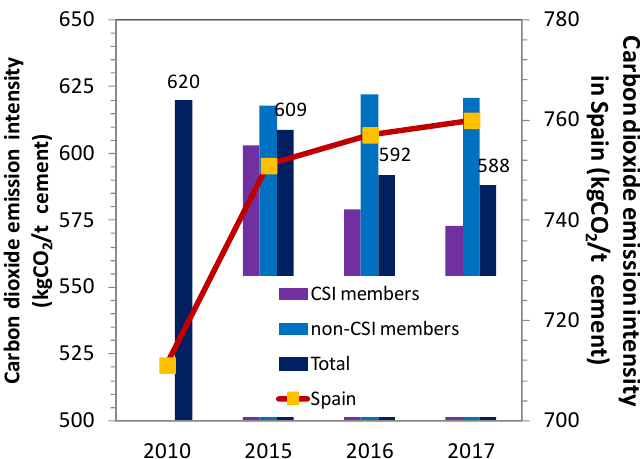
Figure 8. Direct carbon dioxide emission intensity, i.e., emissions from sources controlled by the reporting cement factory, such as emissions from kiln fuels related to clinker production, calcination of carbonates, and combustion of organic carbon from raw materials, for the Cement Sustainability Initiative (CSI) and non-CSI members (kg CO 2 /t cement).